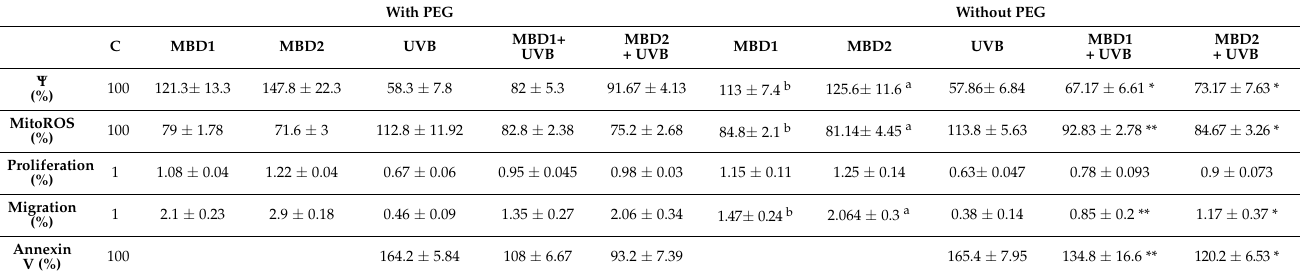
Table 2. Effects of MBD with/without PEG on RGC-5